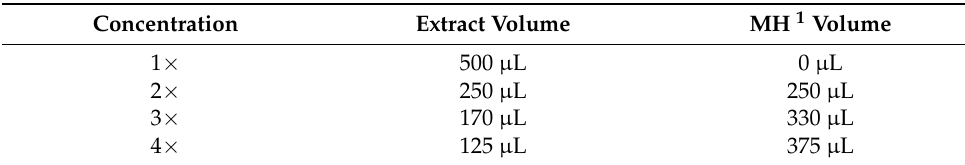
Table 6. Extract concentrations of cured epoxy compounds. Concentration